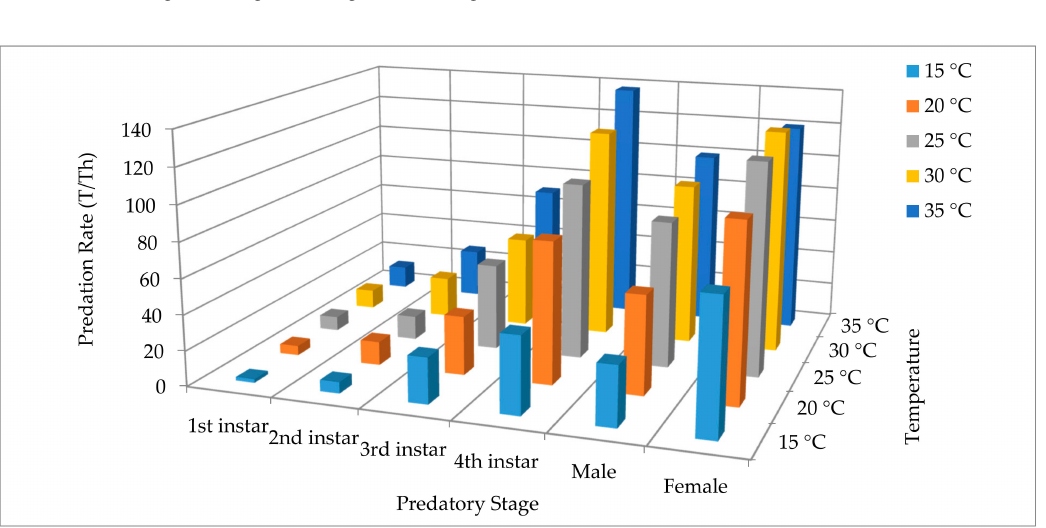
Figure 2. Comparison of the theoretical maximum predation rates for all the predatory stages of Harmonia axyridis on Spodoptera litura eggs at five di ff erent